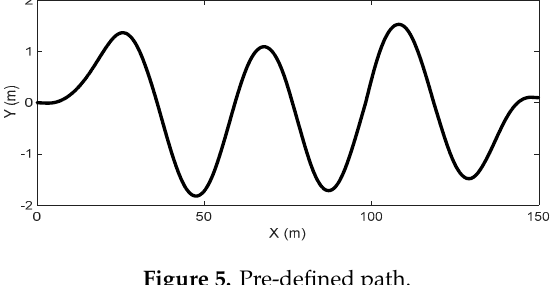
Figure 6. Structure of RBFNN. The fixation of the number of hidden neurons is determined by Kolmogorov theorem. According to the theorem, the calculation of the number is done based on 2 𝑛 (cid:3041) + 1 formula, where 𝑛 (cid:3041) indicates the number of network input. Thus, based on that principle, the quantity of the hidden neurons used in this study is three for both driver’s and passenger’s model. The data collection for the modeling purpose was realized by conducting an experiment that provokes MS. The prediction model developing process requires real time data of lateral acceleration and head roll responses. The experiment procedures are inspired by the previous works of Wada et al. [29]. Figure 7 illustrates the designated course. It is a slalom course where six cones are placed on 150 m road with 20 m gaps between each other. The nominal frequency of lateral acceleration during the slalom test is around 0.2 Hz ; a frequency that can aggravates MS. Figure 7. Designated course for data collection experiment.